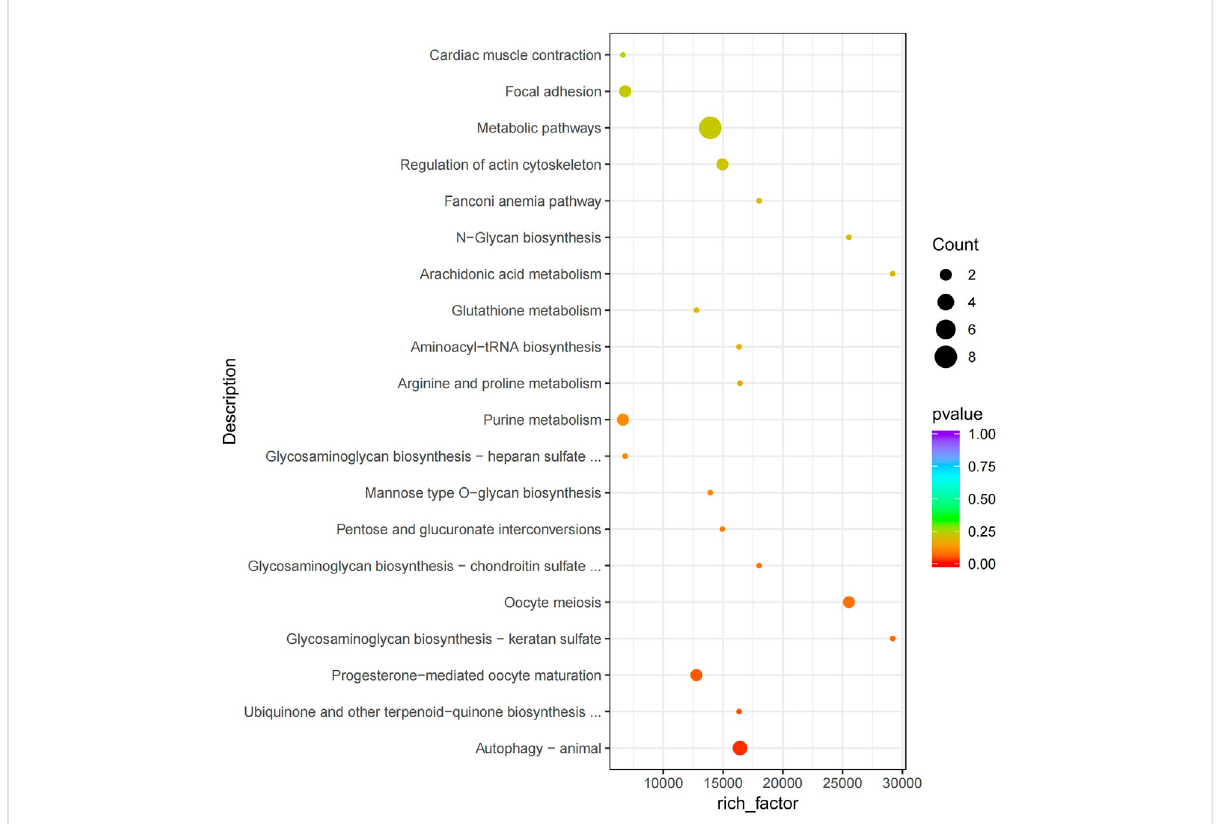
FIGURE 8 KEGGenrichmentmap.Theverticalaxisrepresentsthepathwayname,thehorizontalaxisrepresentsrichfactor,thesizeofthepointrepresents the number of differentially expressed genes in this pathway, and the color of the point corresponds to different p value ranges.